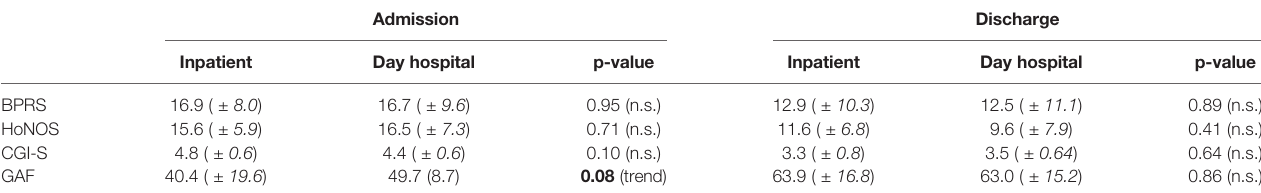
TABLE 4 | Brief Psychiatric Rating Scale (BPRS) and Health of the Nation Outcome Scales (HoNOS), mean sum scores (± standard deviation) ; Clinical Global Impression Severity Score (CGI-S) and Global Assessment of Functioning (GAF), means; p-values (t-tests, inpatient versus day